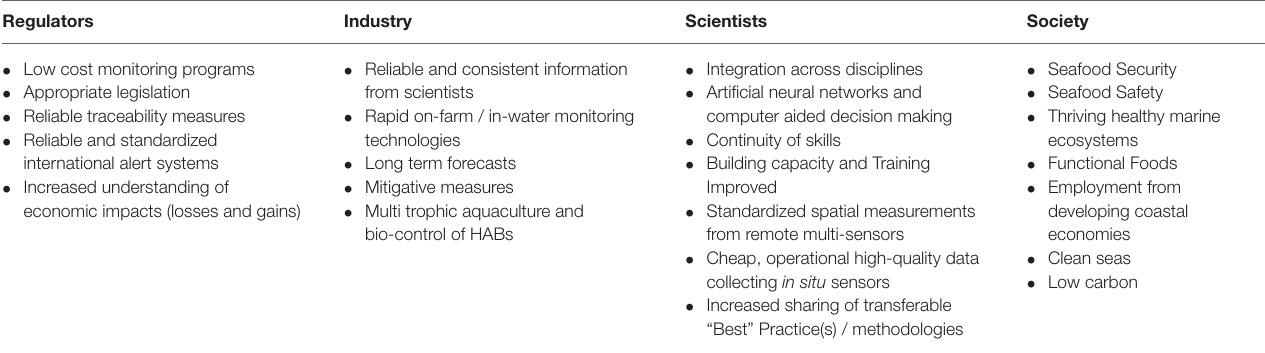
TABLE 1 | Future needs of different sectors in the European Union (also found at www.coclime.eu/node/132).